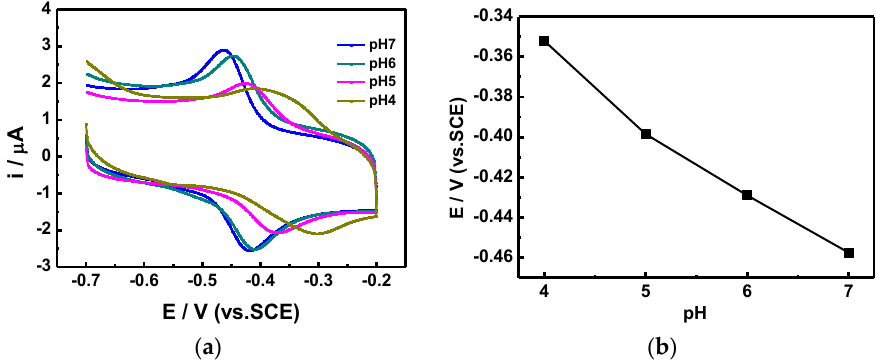
Figure 8. ( a ) CV profile of the GO x /SnS/GCE sensor under different pH values, and ( b ) the linear plotting of the E/V vs. pH values.